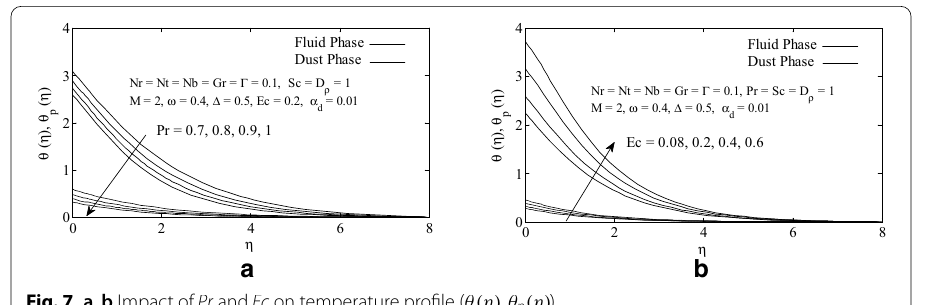
Fig. 7 a , b Impact of Pr and Ec on temperature profile ( θ(η) , θ p (η) )